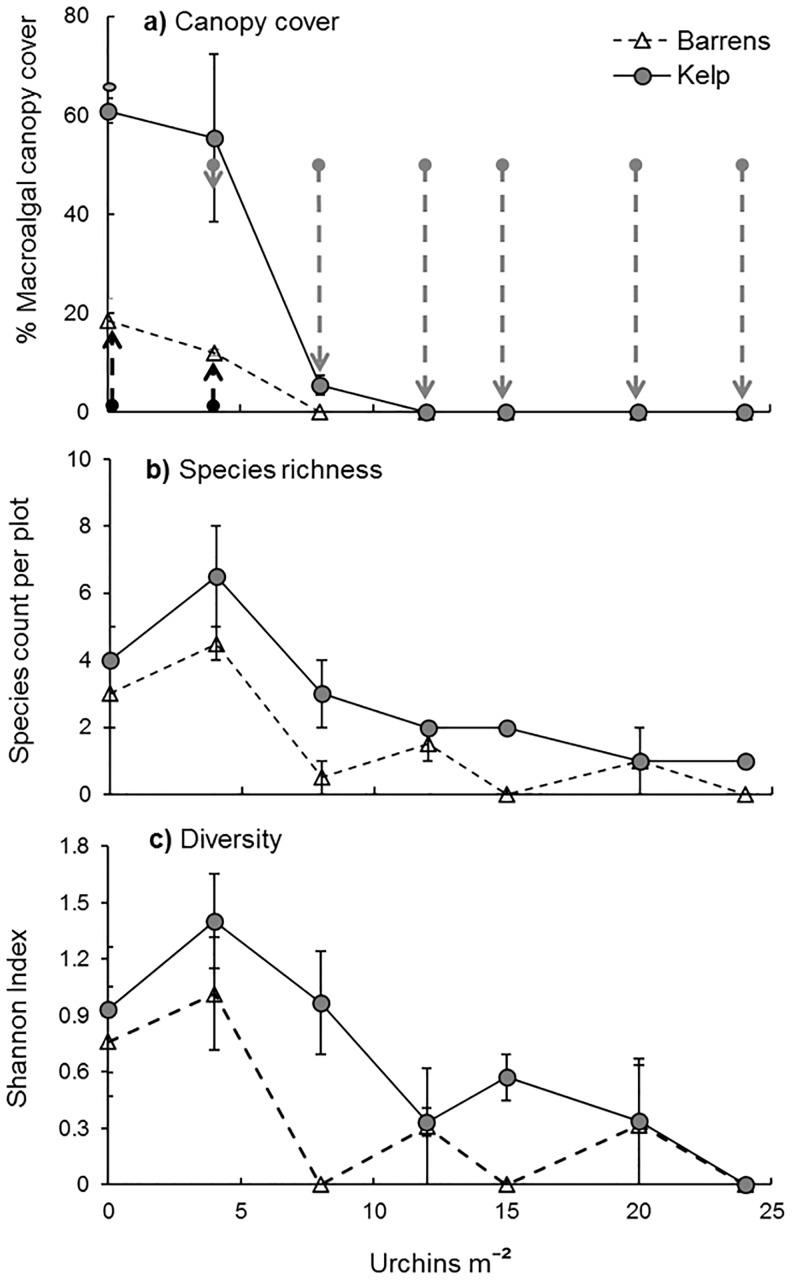
Dependence of algal species richness and diversity on canopy cover.Panel a) details cover of canopy-forming algae, b) shows macroalgal species richness, and c) macroalgal species diversity, against sea urchin densities at the end of the 13 month experimental period. Reefs with initial states of ‘kelp bed’ and ‘urchin’ barrens’ are indicated by a grey circle and a white triangle respectively; data are means ± SE. Reefs with enhanced nutrients have been pooled with reefs with ambient nutrient conditions since the addition of fertiliser did not influence response variables (see Tables 2 and 3). Note that species present at the start of the experiment (E. radiata for kelp bed reefs and encrusting red algae for all reefs) were excluded from the analysis. Arrows in (a) show responses to experimental manipulation of sea urchin biomass in kelp beds (thick grey arrows = forward-shift ‘collapse’ from kelp to urchin barrens) and on sea urchin barrens (thin black arrows = reverse-shift ‘recovery’ from urchin barrens back to kelp beds).